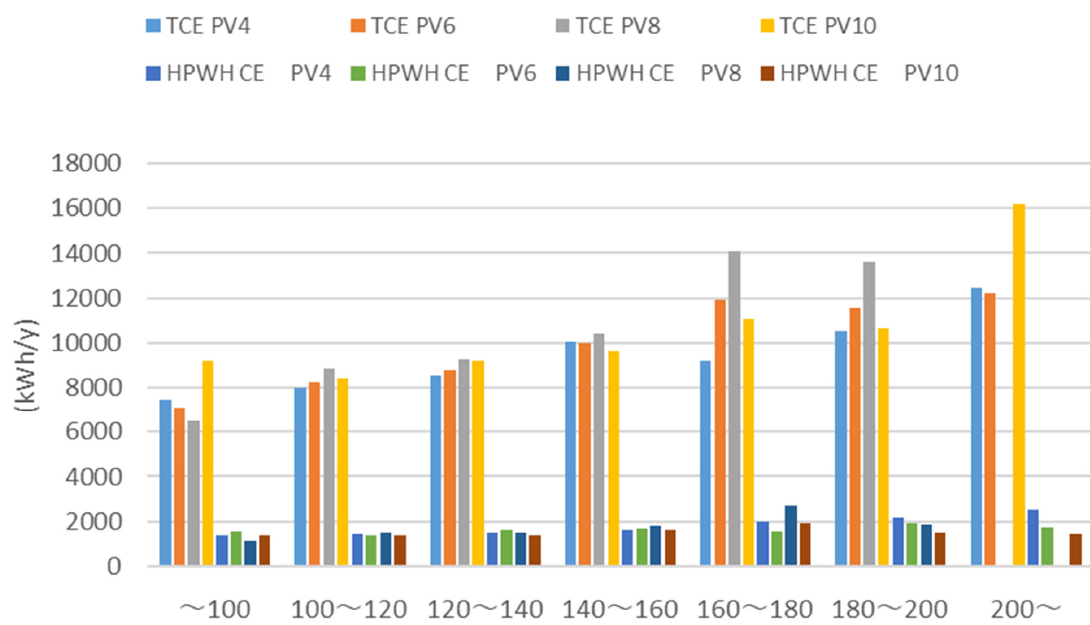
Figure 15. Annual power consumption and HPWH of floor space.